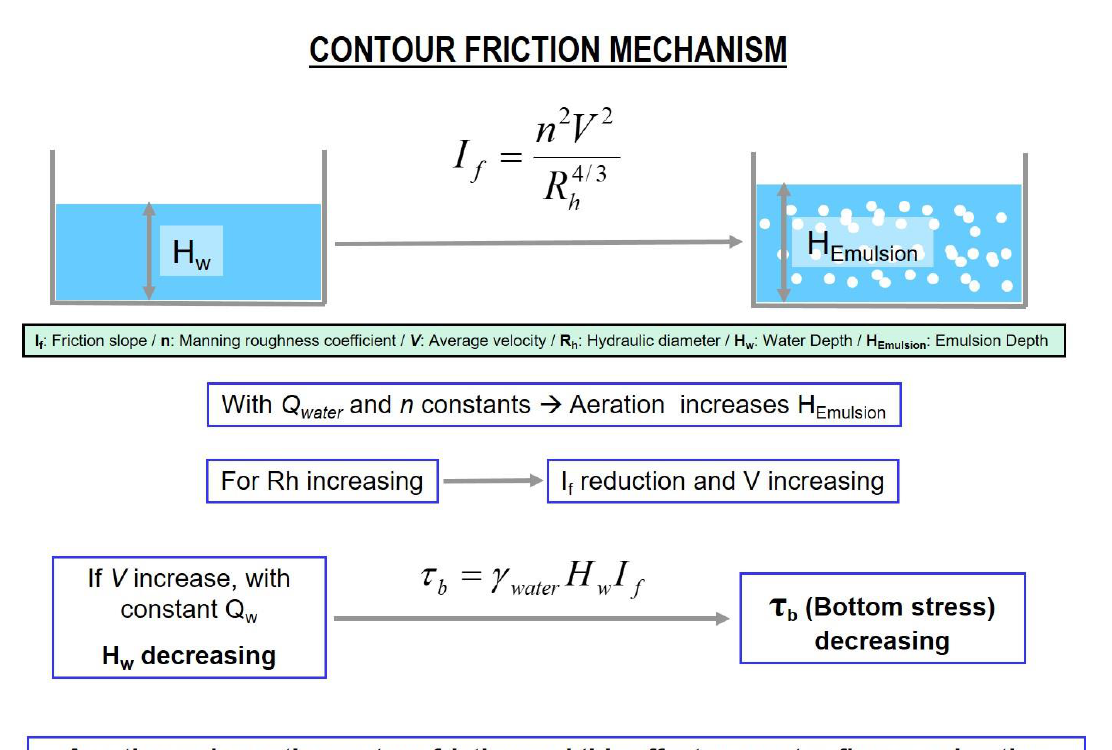
Figure 13. Scheme of the aeration effects over the boundary friction.